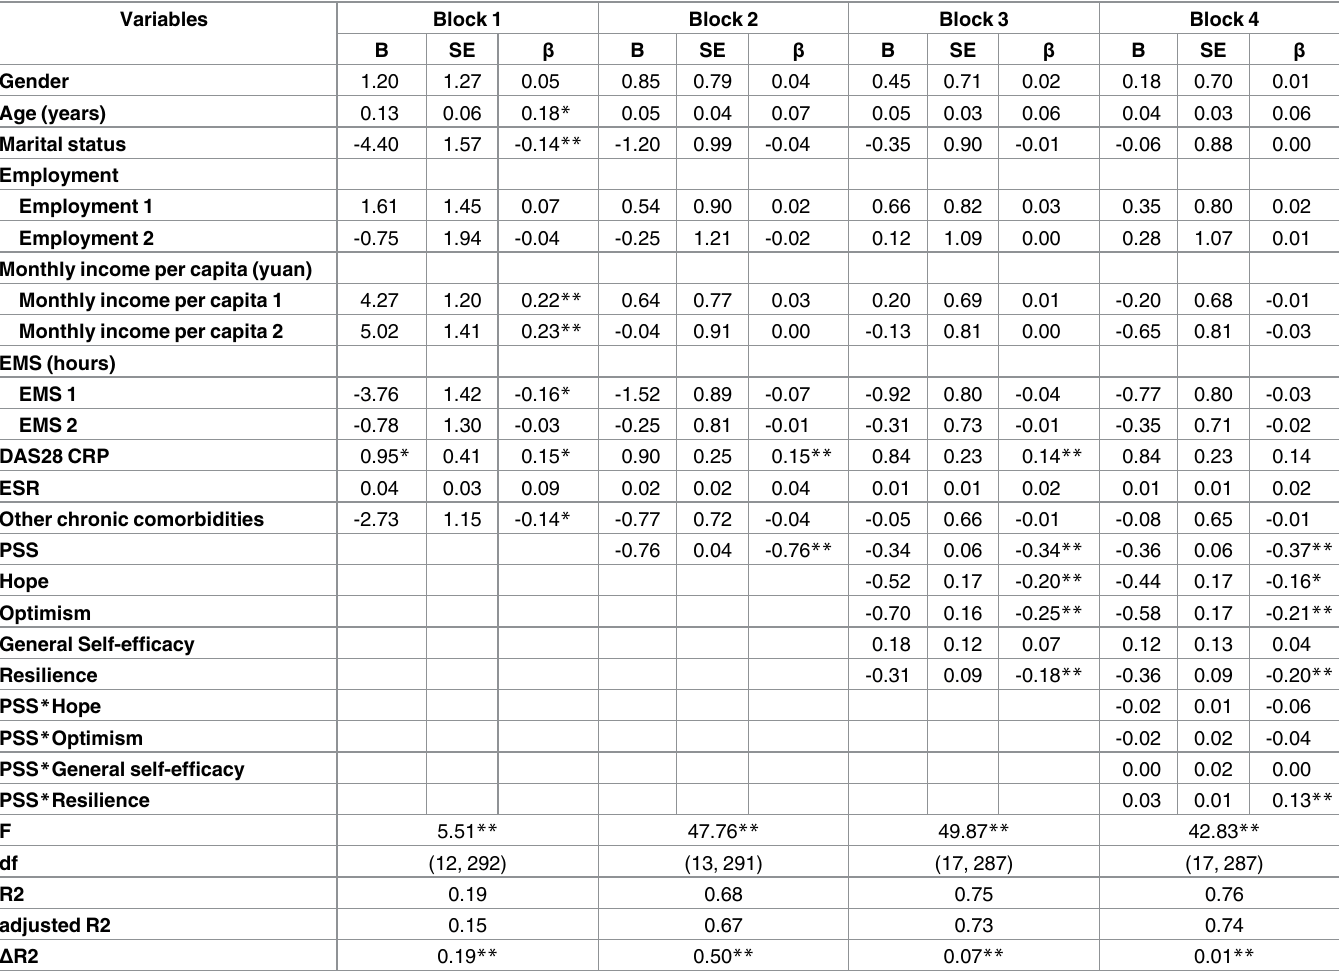
Table 3. Associations of PSS, positive psychological constructs with fatigue and moderating roles of positive psychological